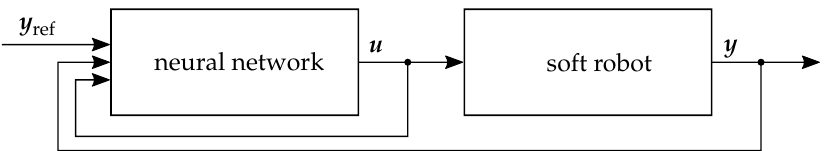
Figure 6. Block diagram of the closed control loop with the neural network as